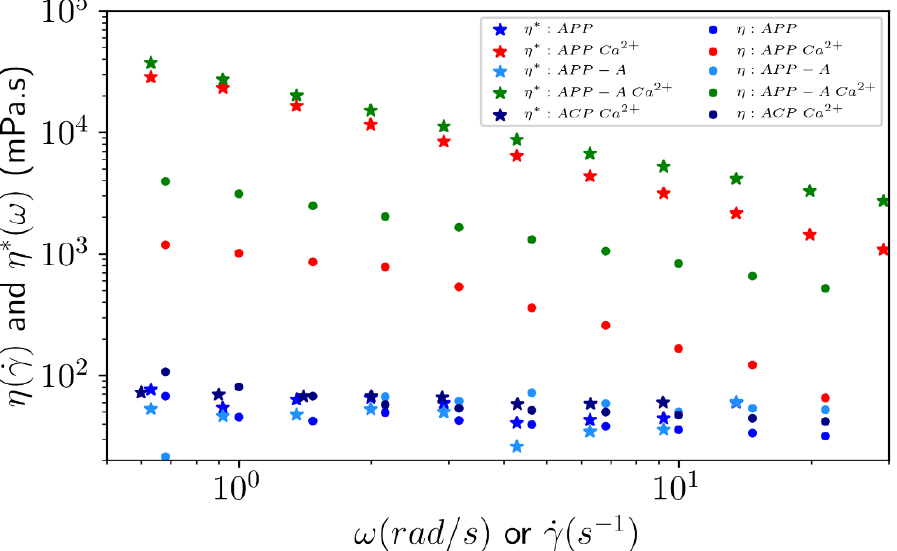
Figure 6. Shear (dots) and dynamic (stars) viscosity as a function of the shear rate and angular frequency, respectively, for ACP, APP, and APP-A, prepared under sodium salt form at 10 g L − 1 , with or without dialysis against 1 mol L − 1 CaCl 2 at 25 ◦